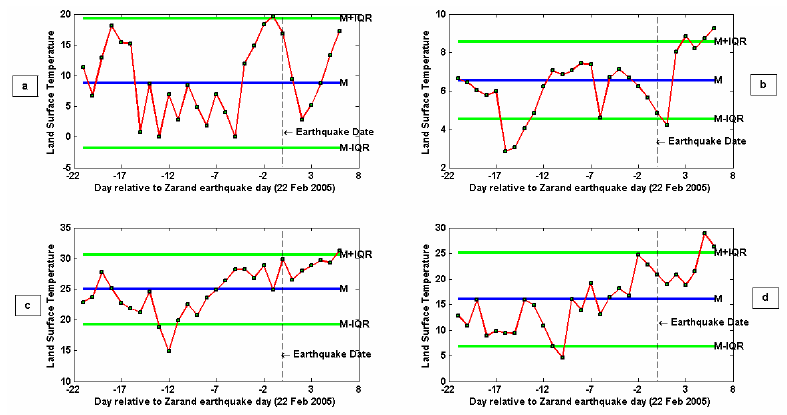
Fig. 11. Same as Fig. 10 but for the Zarand earthquake (22 February 2005) from 1 February to 28 February Figure 11. Same as Figure 10 but for the Zarand earthquake (22 February 2005) from 01 February 3